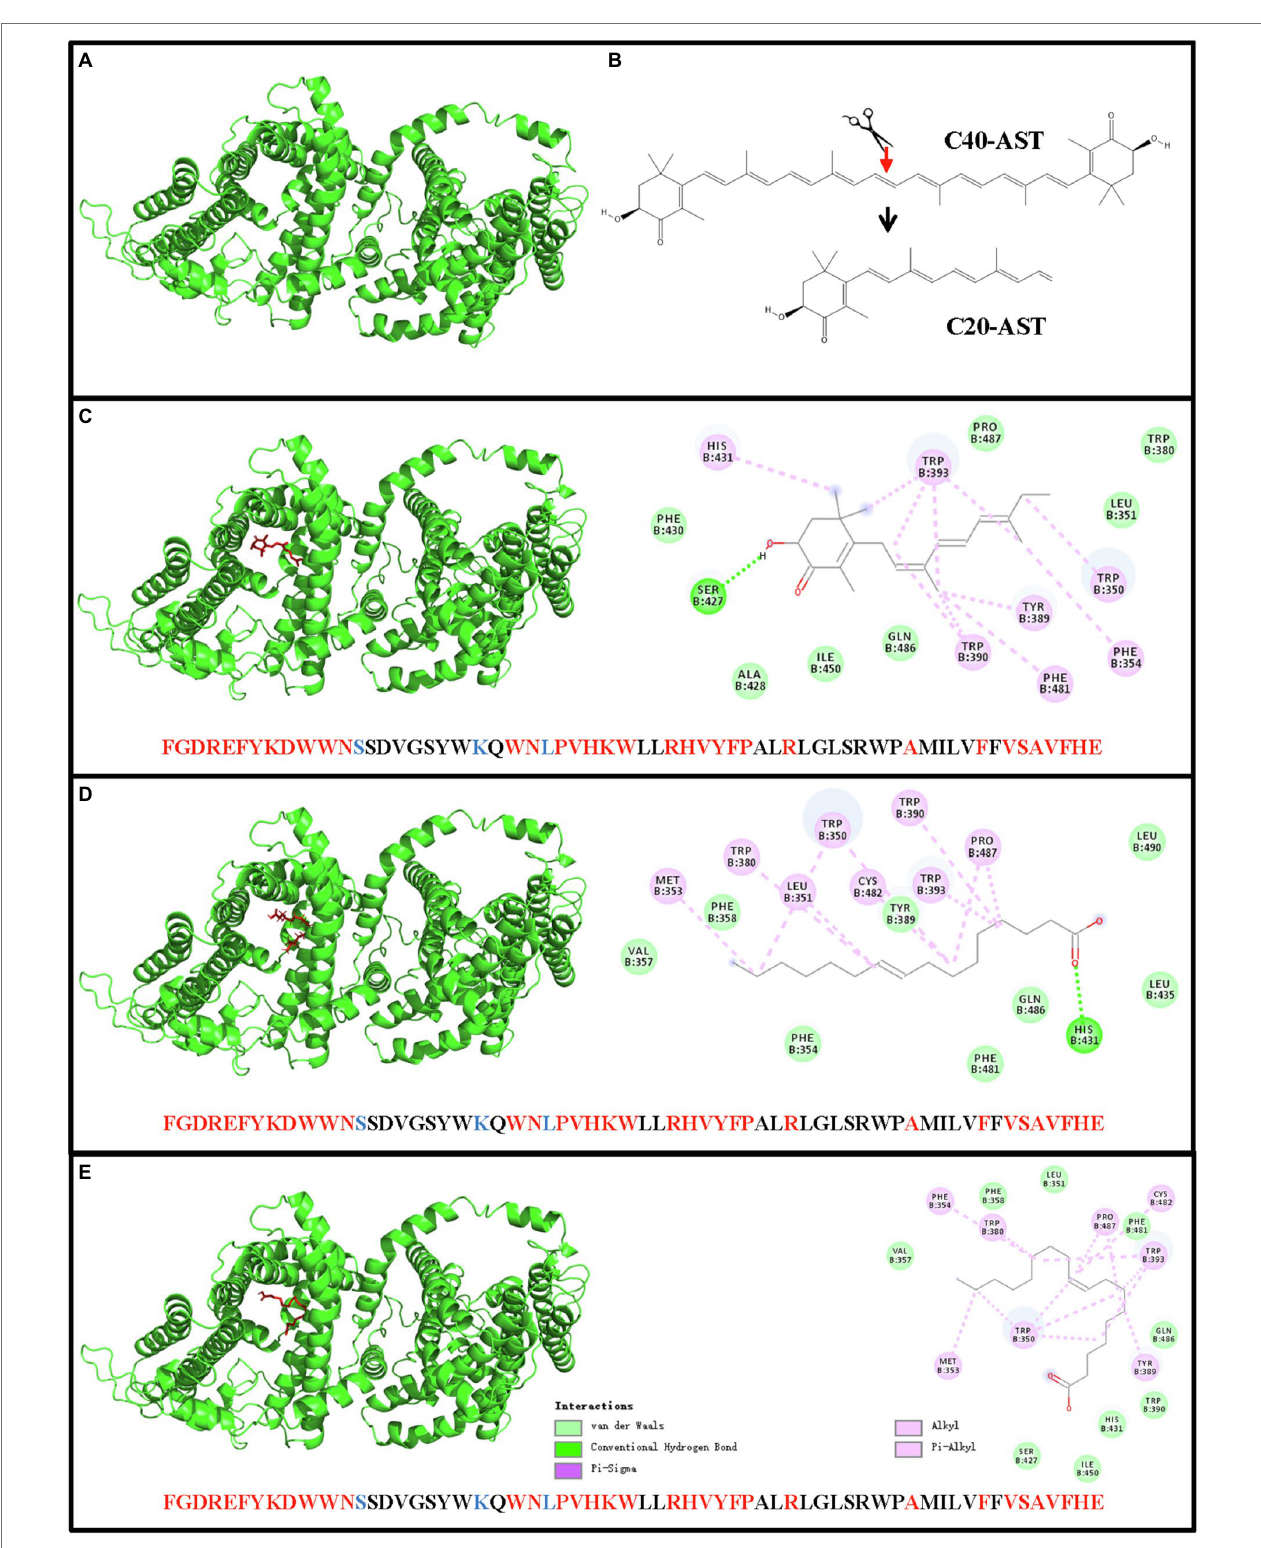
FIGURE 5 | Docking of AST molecular and 3D model of HpDGAT1 using AutoDock software. (A) The 3D model of HpDGAT1. (B) AST molecular. (C) Binding sites between AST and HpDGAT1. (D) Binding sites between C16:1 and HpDGAT1. (E) Binding sites between C18:1 and HpDGAT1. The predicted AST-binding sites were located in CM6, CM7, and CM8. The conserved amino acid residues and substitutions were indicated by red and blue color,